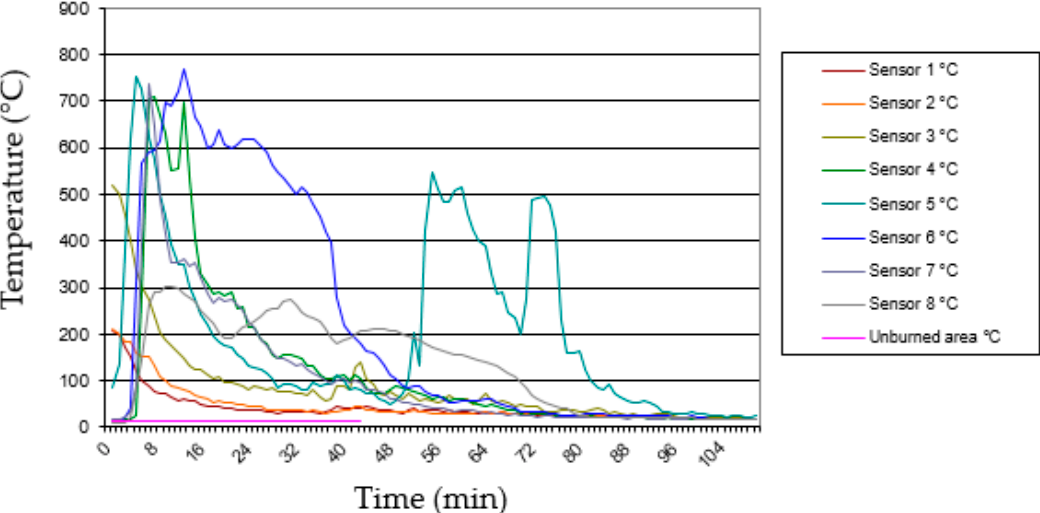
Figure 3. Course of temperatures at the soil surface where the sensors and nets with weed seeds were placed during the fire, 28 October. Maximum temperatures between 205 °C to 768 °C.